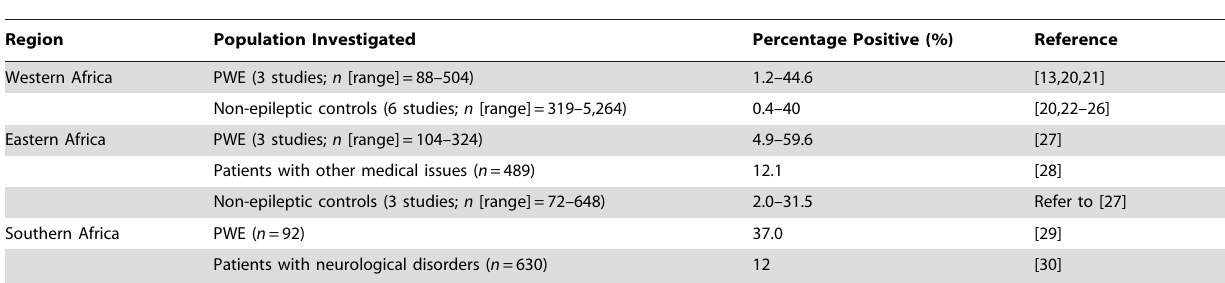
Table 2. Serologic Studies of Human Cysticercosis/Neurocysticercosis in Sub-Saharan Africa.